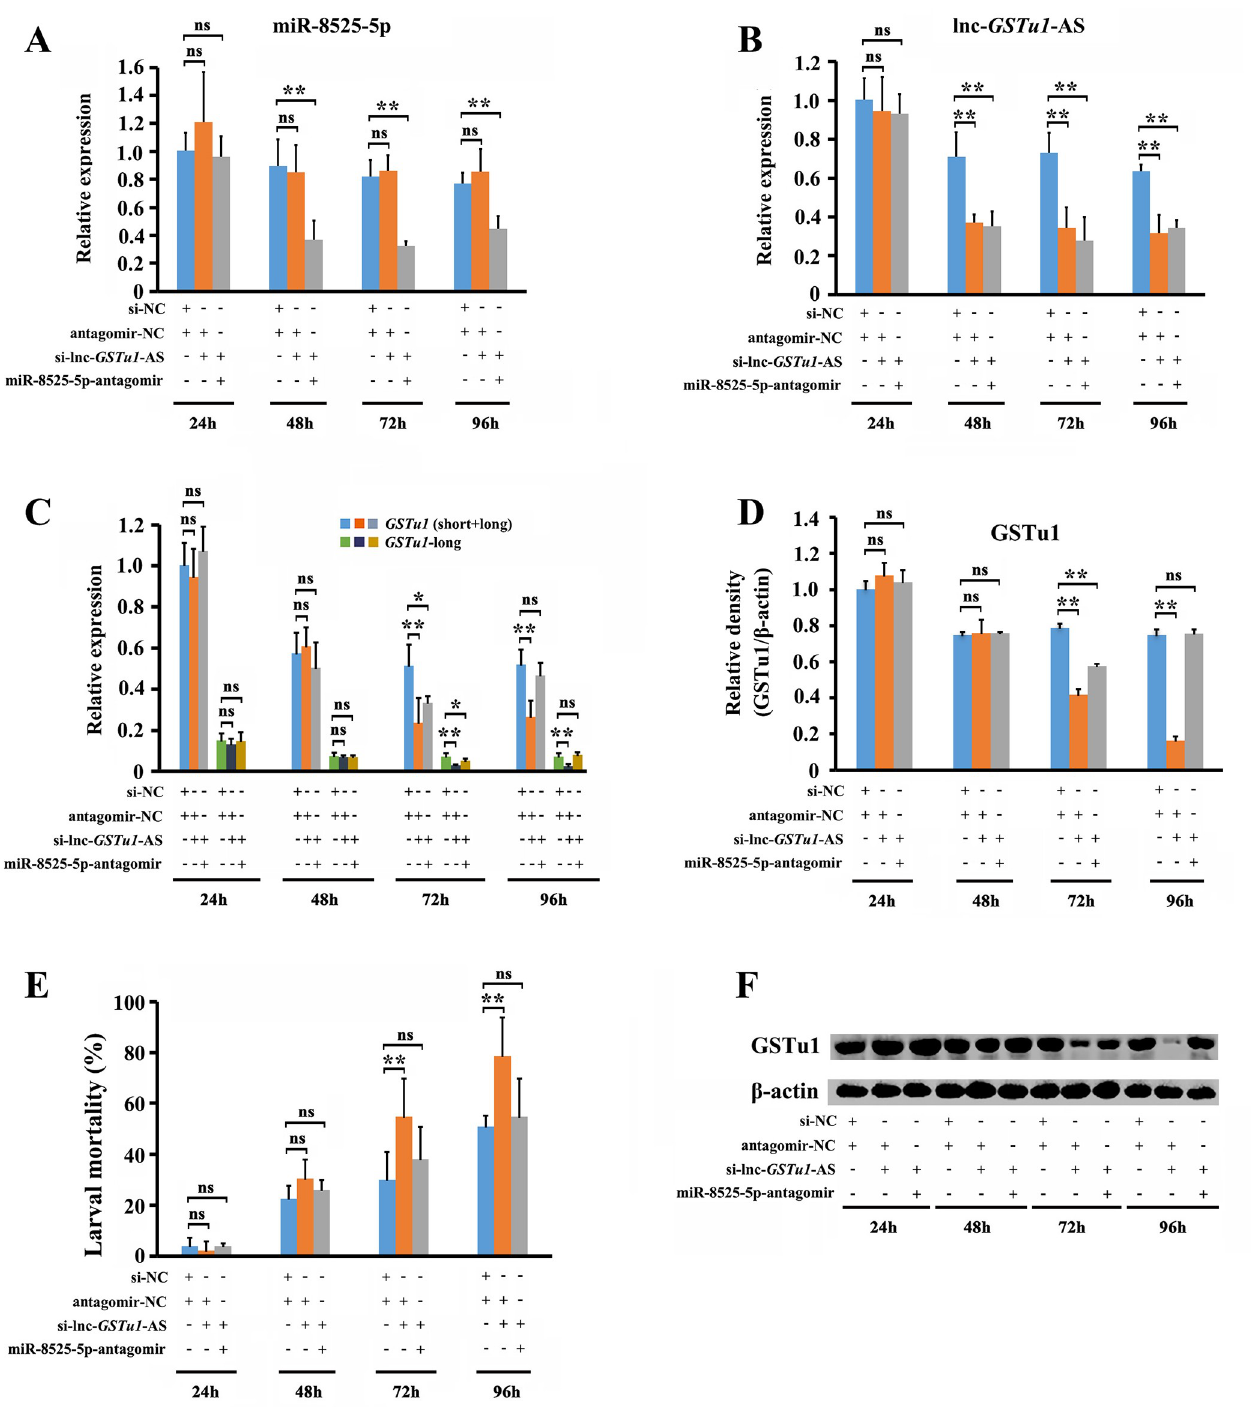
Fig 7. Lnc- GSTu1 -AS maintains the stability of GSTu1 through prevention of its degradation by masking the binding site of miR-8525-5p in chlorantraniliprole-resistant P . xylostella . Relative expression of miR-8525-5p (A) and lnc- GSTu1 -AS (B) after inhibition of miR-8525-5p and knockdown of lnc- GSTu1 -AS by qRT-PCR. Relative expression of GSTu1 after inhibition of miR-8525-5p combined with knockdown of lnc- GSTu1 -AS by qRT-PCR (C) and Western blot assay (D, F). E: Mortality of P . xylostella treated with the LC 50 of chlorantraniliprole. Asterisks indicate significant differences between the treatment and the corresponding control (Student’s t -test, ns indicates no significant differences, � 0.01 < P < 0.05, �� P < 0.01).